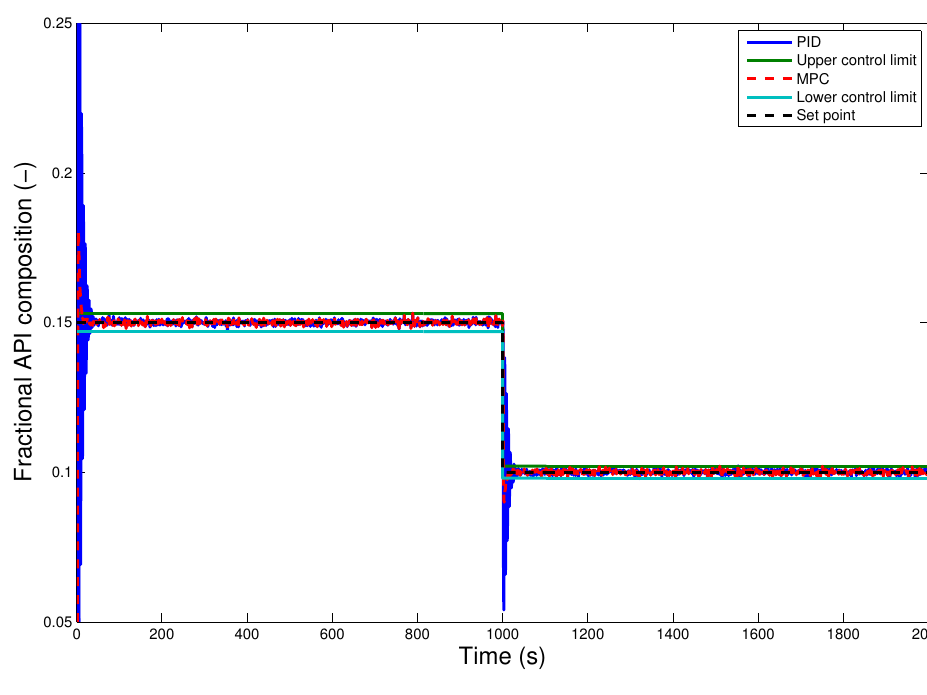
Figure 10. Controller performance evaluation for the set point tracking of the API